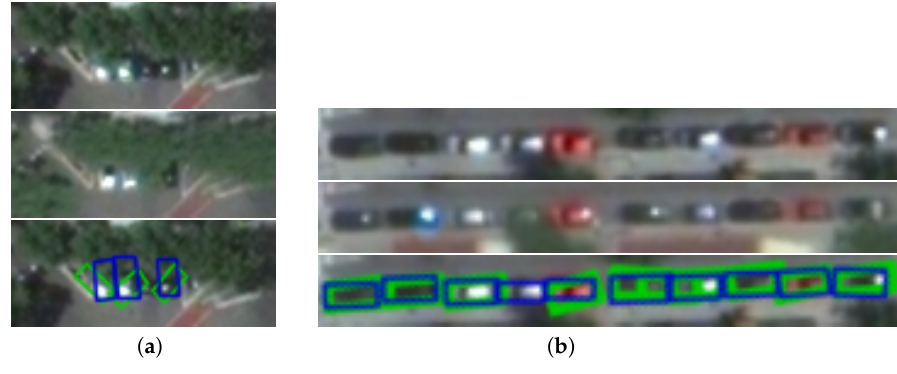
Figure 8. Problematic conditions leading to individual false detections: ( a ) tree covering and ( b ) densely parked cars (from top to bottom: first stereo image, second stereo image, and detections).